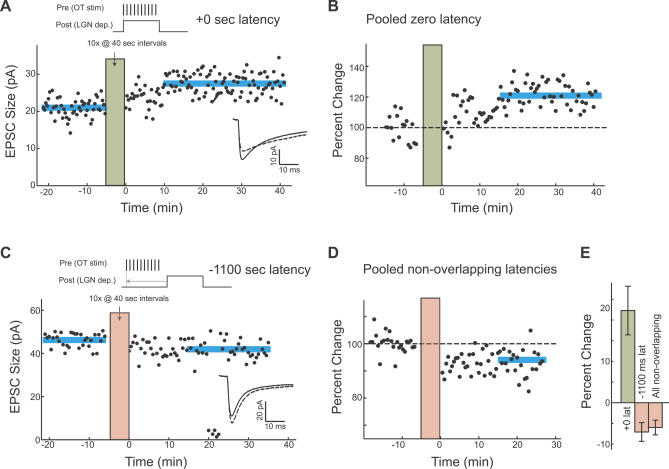
Bidirectional Synaptic Plasticity Evoked by Natural Activity Patterns(A) The maximum current during EPSCs evoked every 30 s throughout the course of a zero-latency pairing experiment (with simultaneous pre- and postsynaptic bursts). Inset: average EPSCs before (dashed) and after (solid) stimulation. As with (B–D), horizontal blue lines represent the mean EPSC size, and vertical green and red boxes demonstrate the duration of the stimulation protocol.dep., depolarization; stim, stimulation.(B) Summary of all zero-latency experiments, showing an average increase in synaptic efficacy of 21.3% (n = 7 neurons).(C) A single experiment showing EPSC size for a −1,100-ms latency pairing experiment.(D) Summary over all non-overlapping experiments shows an average −5.9% change in EPSC size (n = 13 neurons).(E) The zero-latency and non-overlapping burst protocols evoke significant changes in synaptic efficacy: summary plot with standard error is shown.